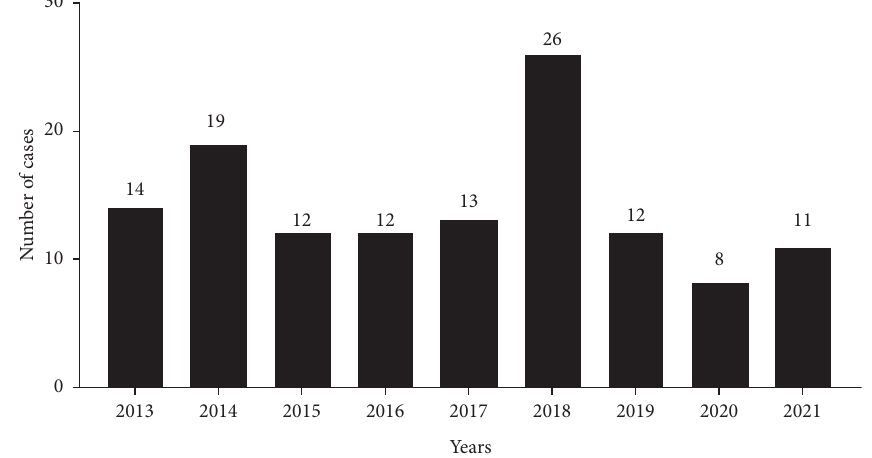
Figure 1: Number of patients with IPD in Ningxia Hui Autonomous Region, China, 2013–2021.